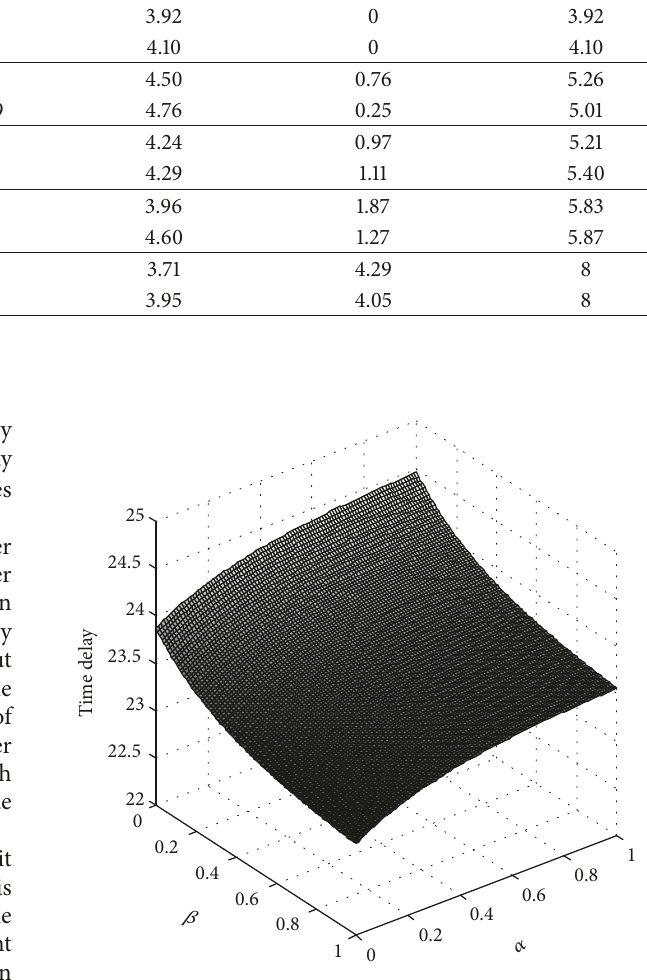
Figure 16: The influence of time delay caused by 𝛼 and 𝛽